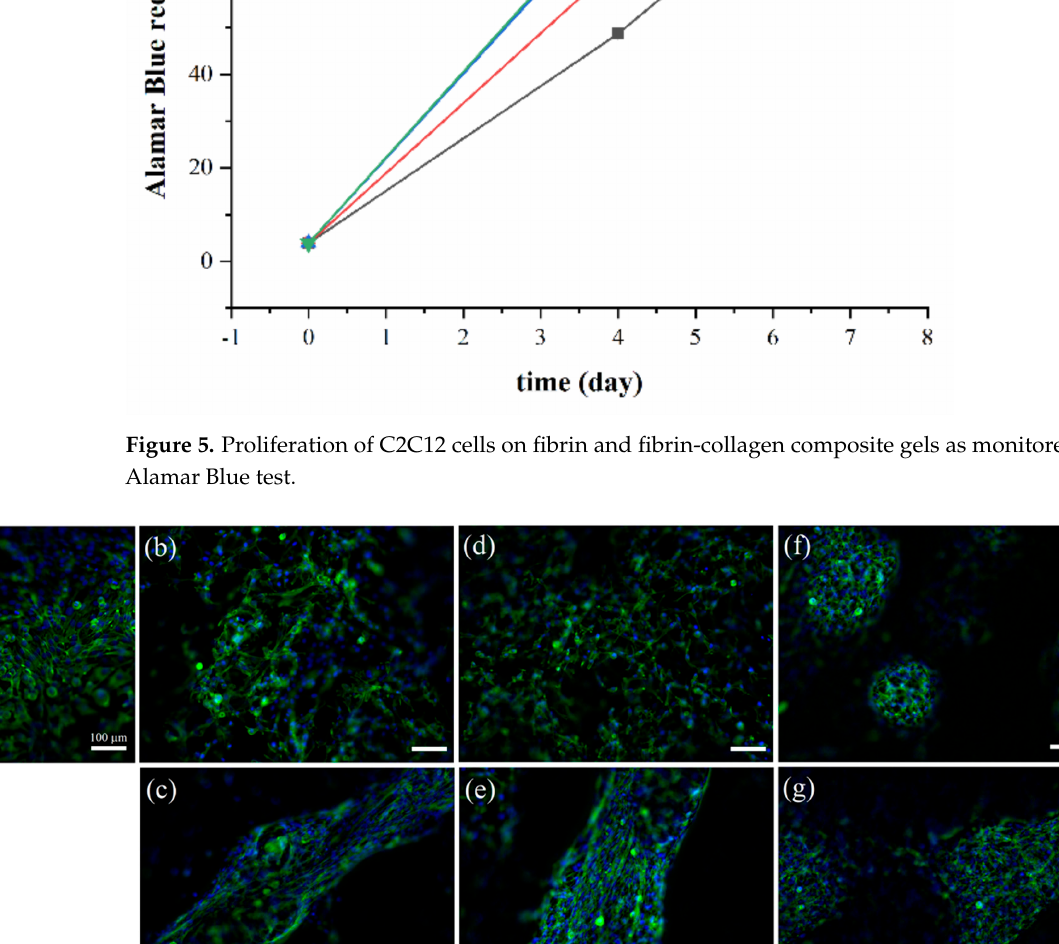
Figure 5. Proliferation of C2C12 cells on fibrin and fibrin-collagen composite gels as monitored by Alamar Blue test.